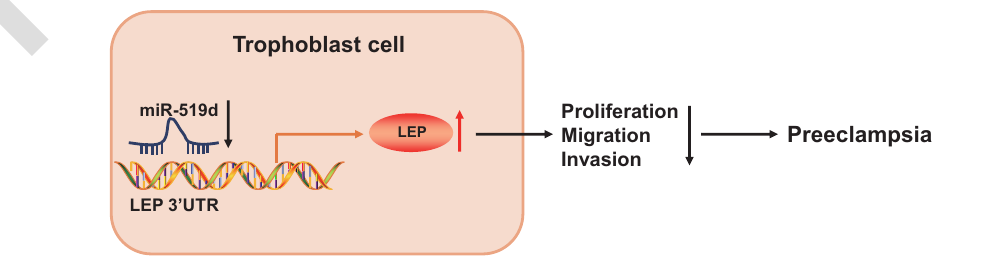
Figure 6: The mechanism diagram of miR - 519d regulating PE development. miR - 519d was poorly expressed in placental tissues of patients with PE, whereas LEP was overexpressed due to negative targeting of LEP by miR - 519d. Overexpressing miR - 519d downregulates LEP to promote the proliferation, migration, and invasion of trophoblast cells, thereby inhibiting the development of